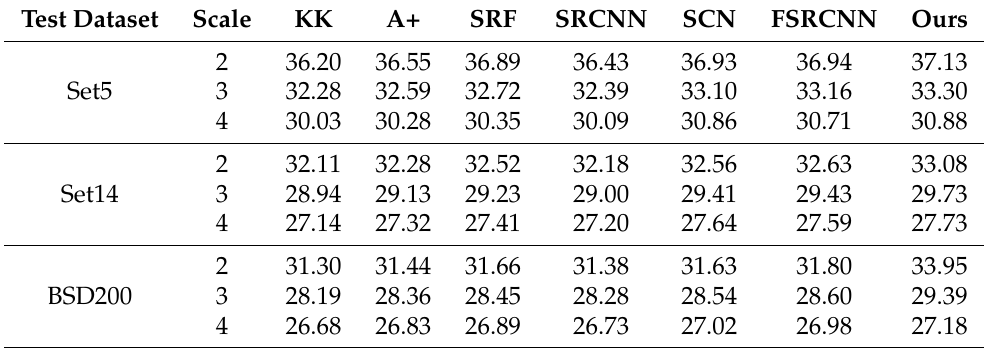
Table 4. The results of PSNR on three datasets in comparison with state-of-the-art methods. EMTCM is trained on the 91-image and General-100 datasets.